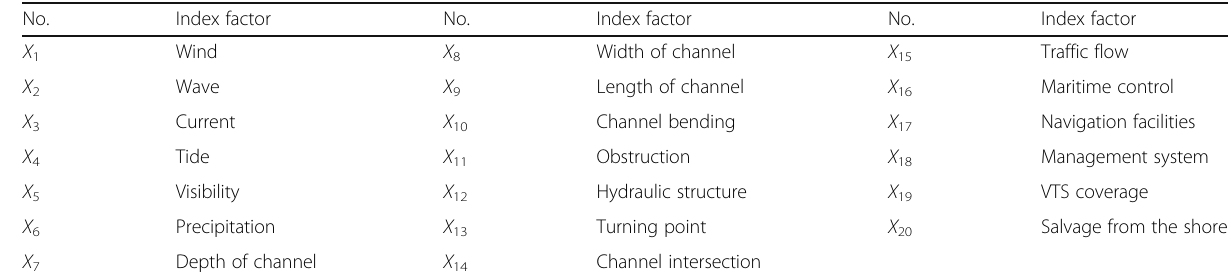
Table 1 Index factors for risks of channel navigation